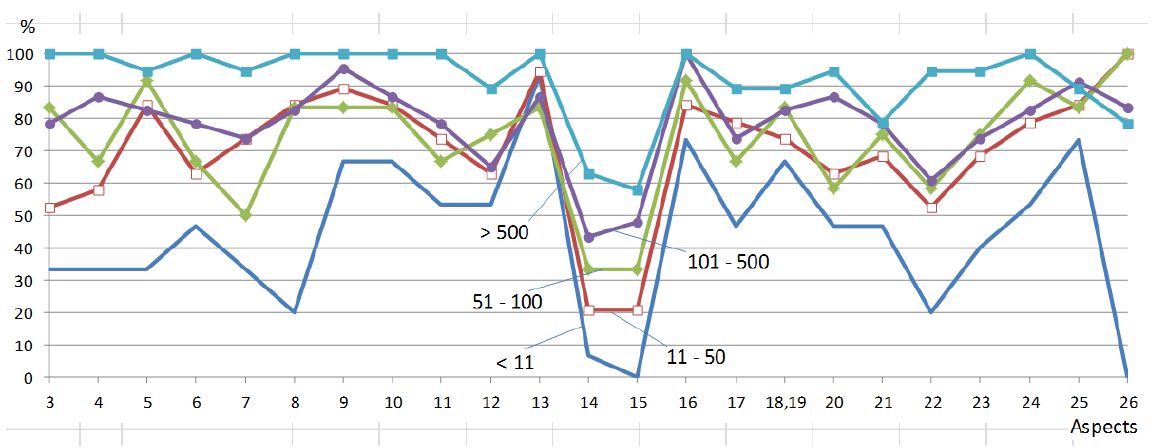
Figure 4. Dependence of %EOIs (at 100% i- security performance), by categories according to the number of employees, on aspects 3 –